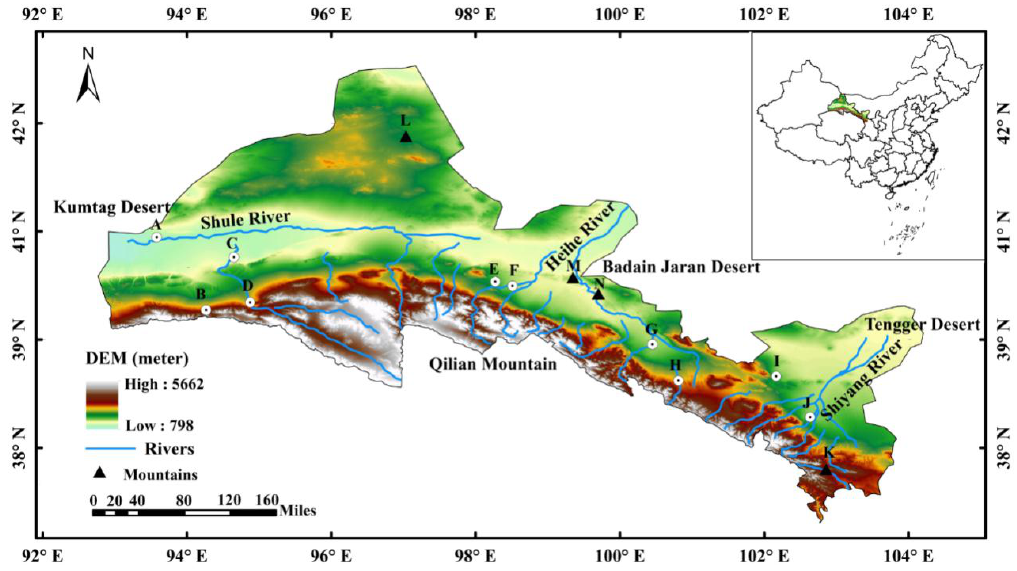
Figure 1. The study area in northwest China. White dots represent study sites ( A – J in this study represent Jade Gate Pass, Akesai, Dunhuang, Subei, Jiayuguan, Jiuquan, Zhangye, Minle, Jinchang, and Wuwei, respectively). Black triangles represent mountains ( K – N in this study represent Wushao Mountain, Mazong Mountain, Heli Mountain, and Longshou Mountain, respectively).